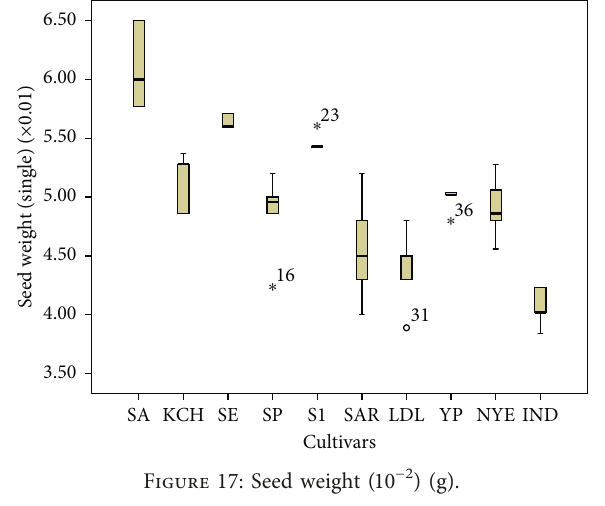
Figure 20: Phenogram presented based on the average linkage (between groups) using the squared Euclidean distance method.